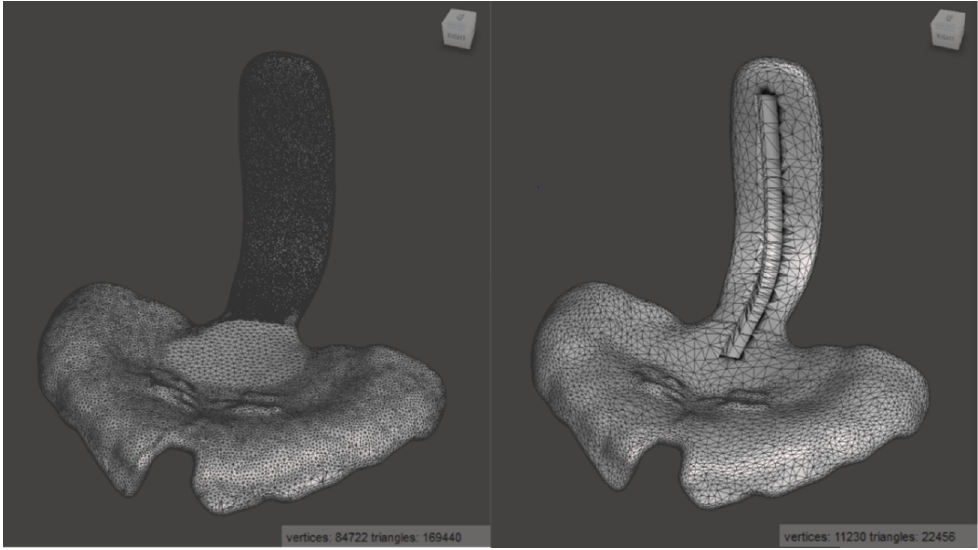
Figure 4. Standard TPP in Meshmixer, before ( left ) and after ( right ) mesh reduction and addition of the groove for the placement of the safety wire.